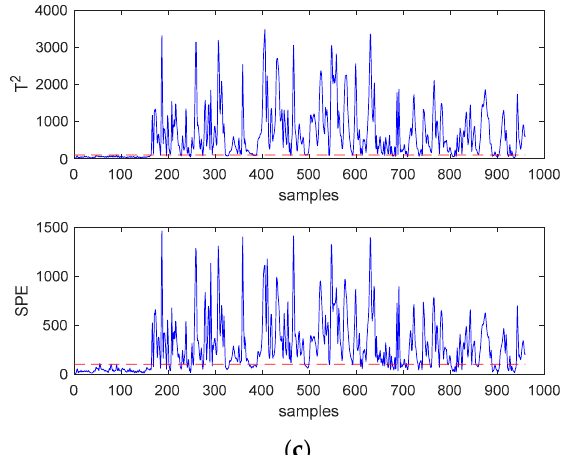
Figure 4. ( a ) Monitoring charts of the principal component analysis (PCA) for fault 11. ( b ) Monitoring charts of GLPP for fault 11. ( c ) Monitoring charts of SWWD-GLPP for fault 11.